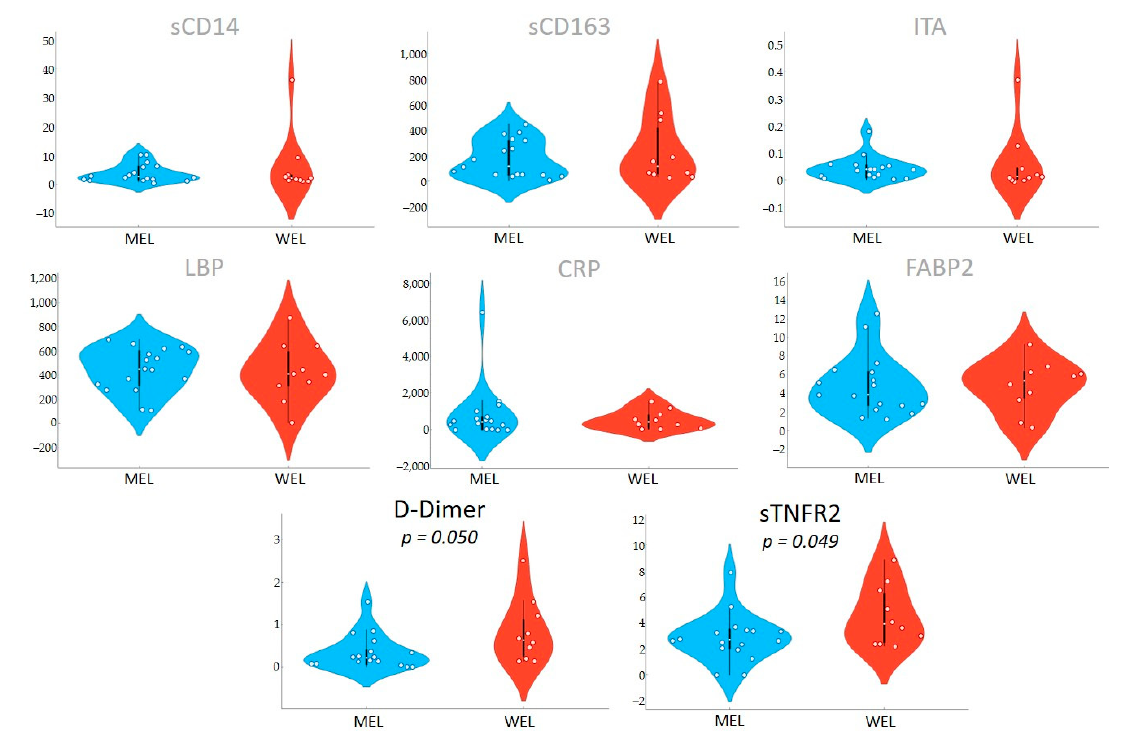
Figure 6. Inflammatory biomarkers by dietary pattern.